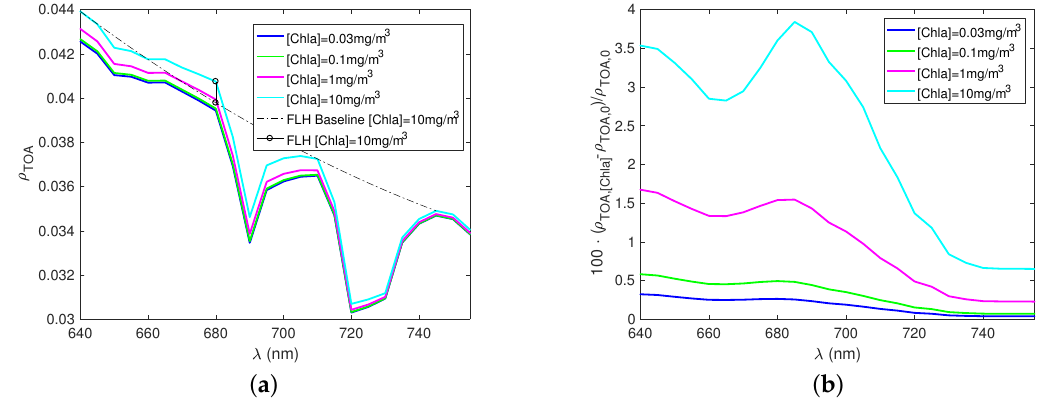
Figure 2. ( a ) The nadir viewing reflectance at TOA as a function of wavelengths for the cases shown in Figure 1. The dash line shows the baseline determined by measurements at 640 nm, 710 nm, and 745 nm for [Chla] = 10 mg/m 3 . The solid line with open circle symbols shows the magnitude of fluorescence line height relative to the baseline for [Chla] = 10 mg/m 3 . ( b ) The percentage ratio of fluorescence signals in the total reflectance observed at